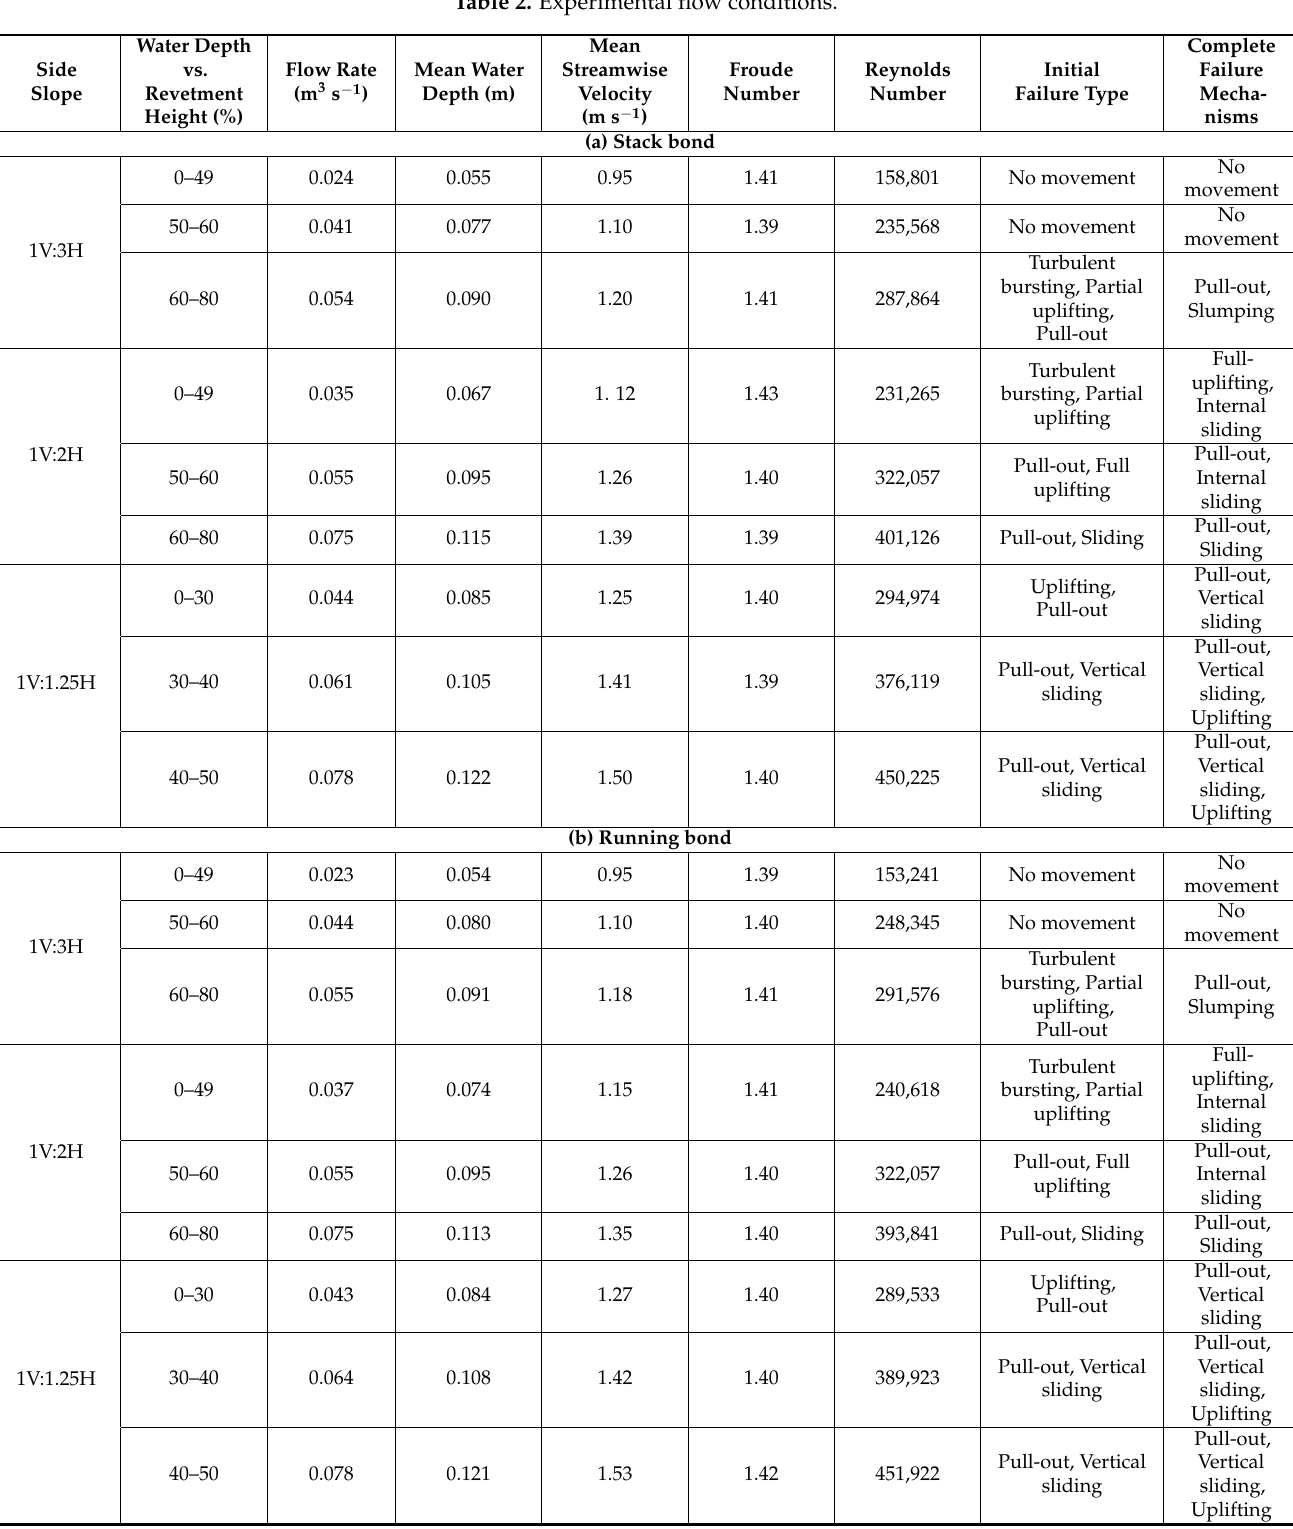
Table 2. Experimental flow